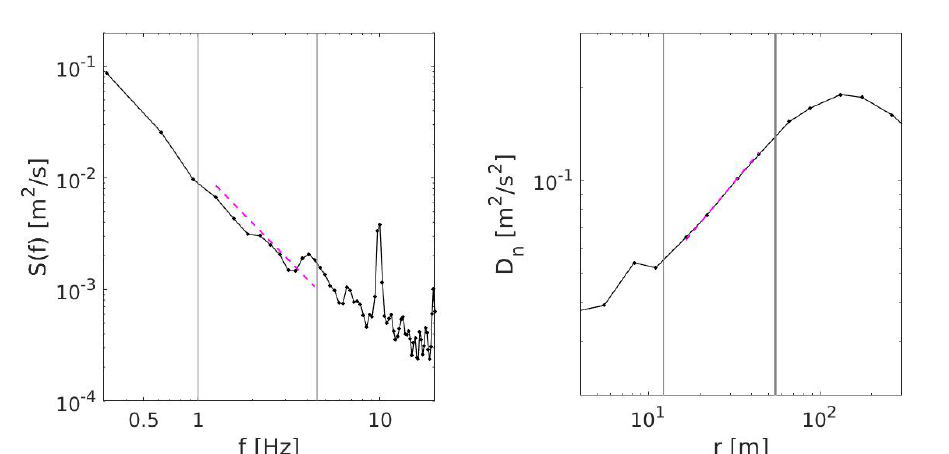
Figure 1. Left : Exemplary frequency spectra of the transverse velocity component from experimental POST data [15], Right : Exemplary second-order structure function. Vertical lines indicate bounds of the fitting range, magenta dashed line is a curve-fit within this